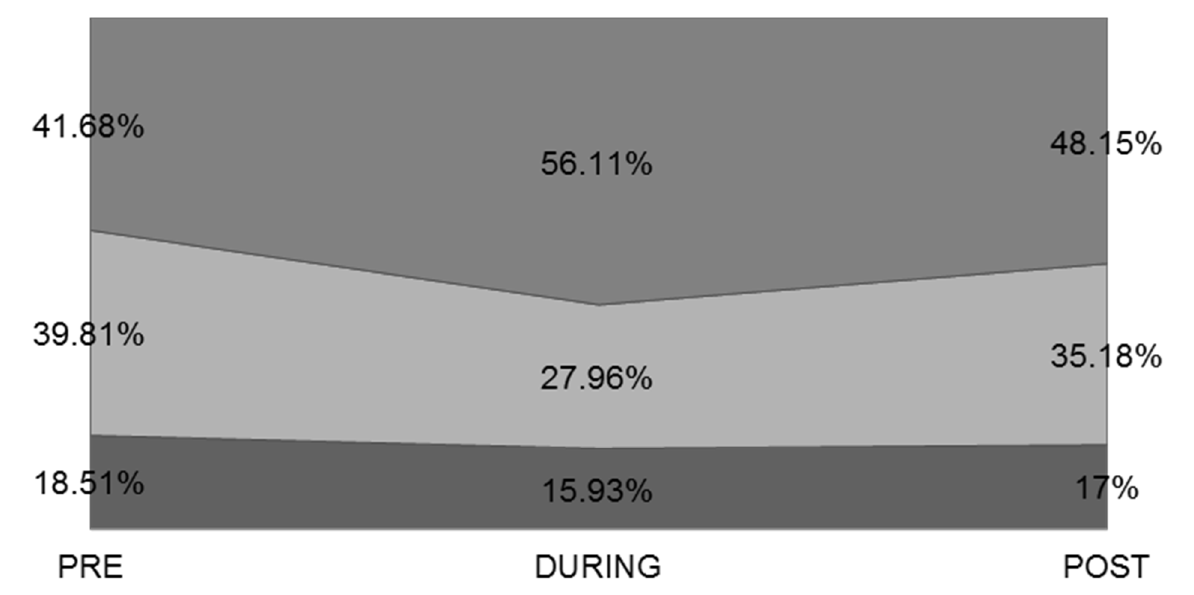
Figure 3. Sleep arrival during quarantine